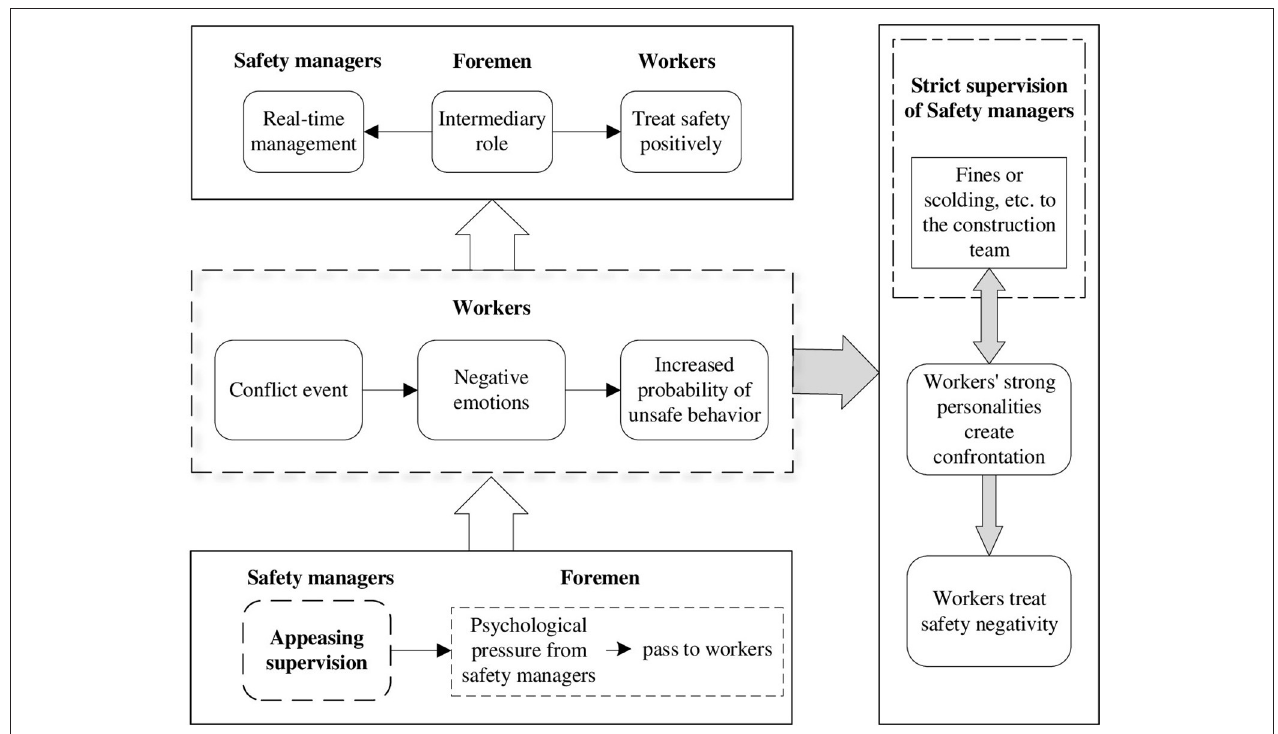
FIGURE 2 | Tripartite relationship